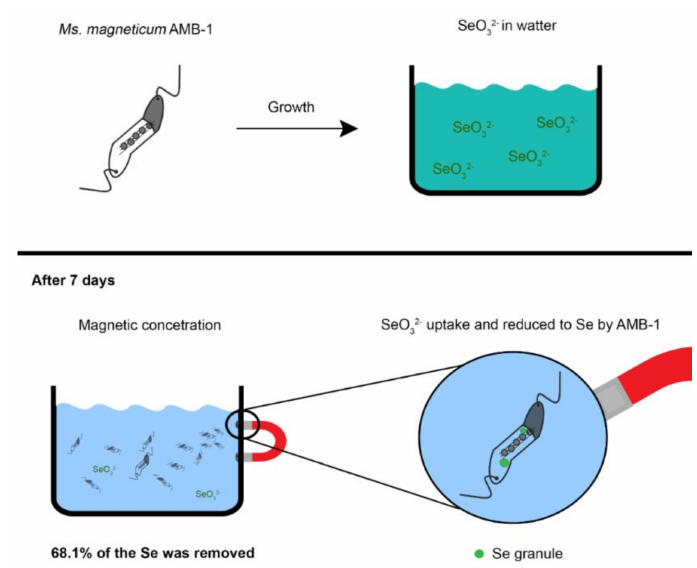
Figure 6. Illustrative scheme showing the magnetic recovery of Se-containing cells of Ms. magneticum strain AMB-1 grown in culture medium containing SeO 32 − . Cells reduced SeO 32 − to Se which accumulated in cells as intracytoplasmic granules (green). After seven days of incubation followed by magnetic separation of the cells, 68.1% of the Se was removed from the medium